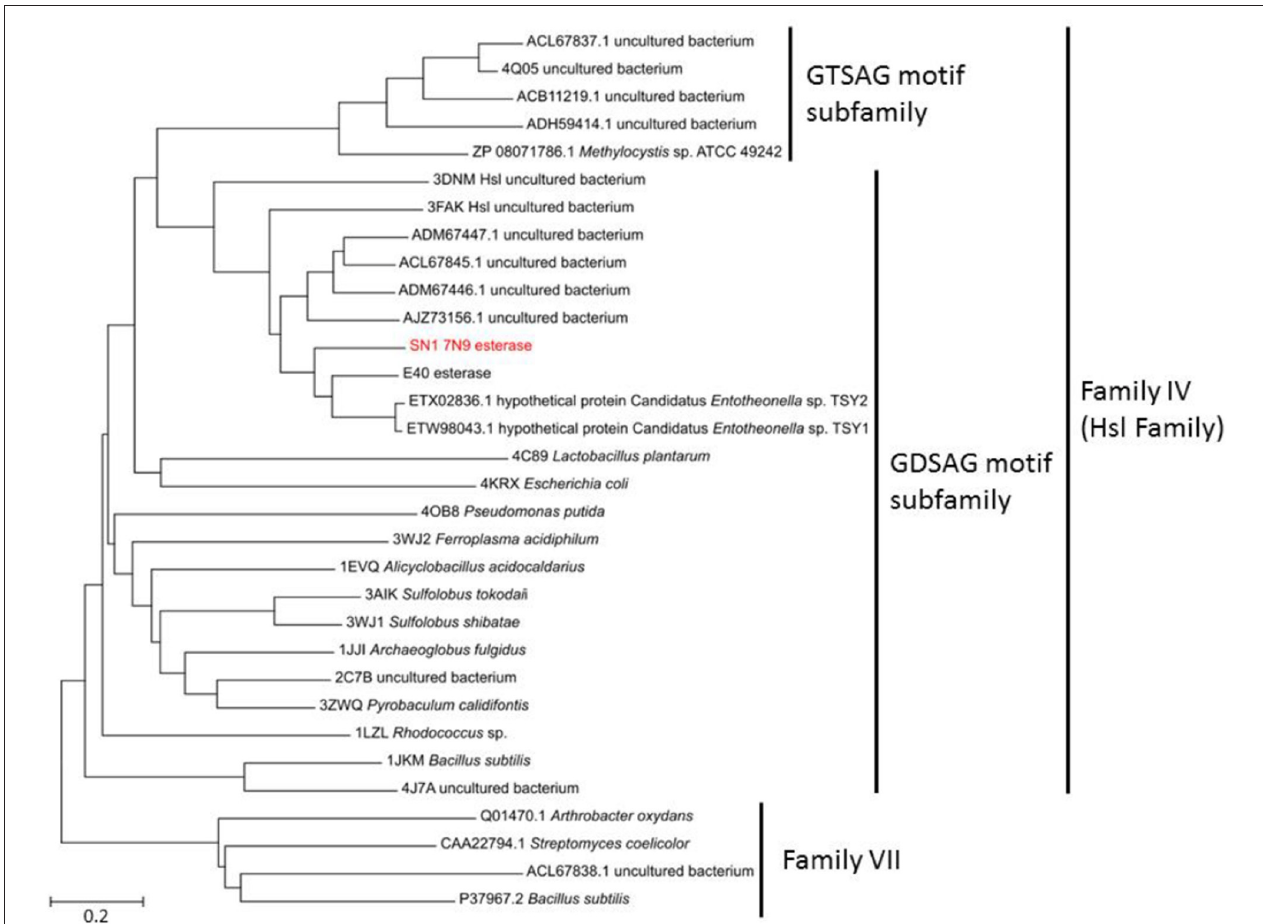
FIGURE 2 | Phylogenetic comparison of the 7N9 esterase and other representative sequences of different lipase families. The phylogenetic tree was built using the neighbor joining method and bootstrap analysis with 500 replicates was conducted, reference sequences from lipase family VII were used as outgroups.